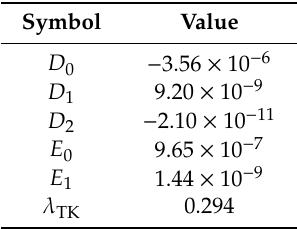
Table 2. The physical parameters of N-SF11 employed in the theoretical calculations